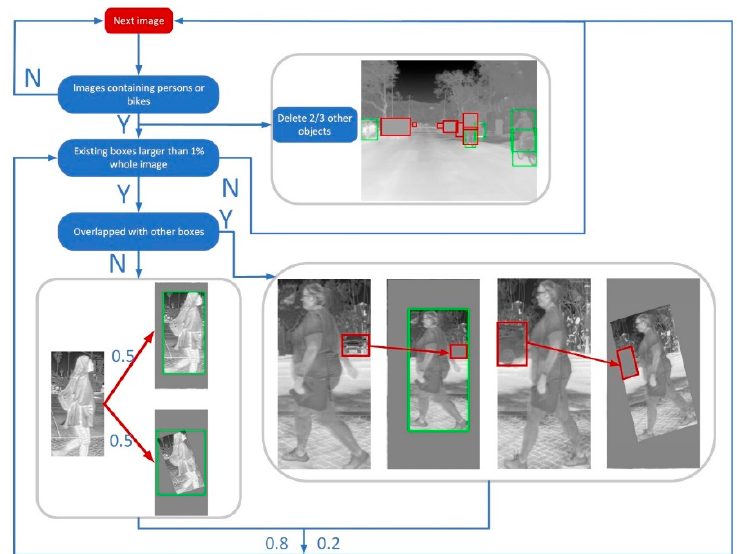
Figure 2. Flow chart of data augmentation algorithm. Green lines indicate annotations, red lines indicate deleted boxes.